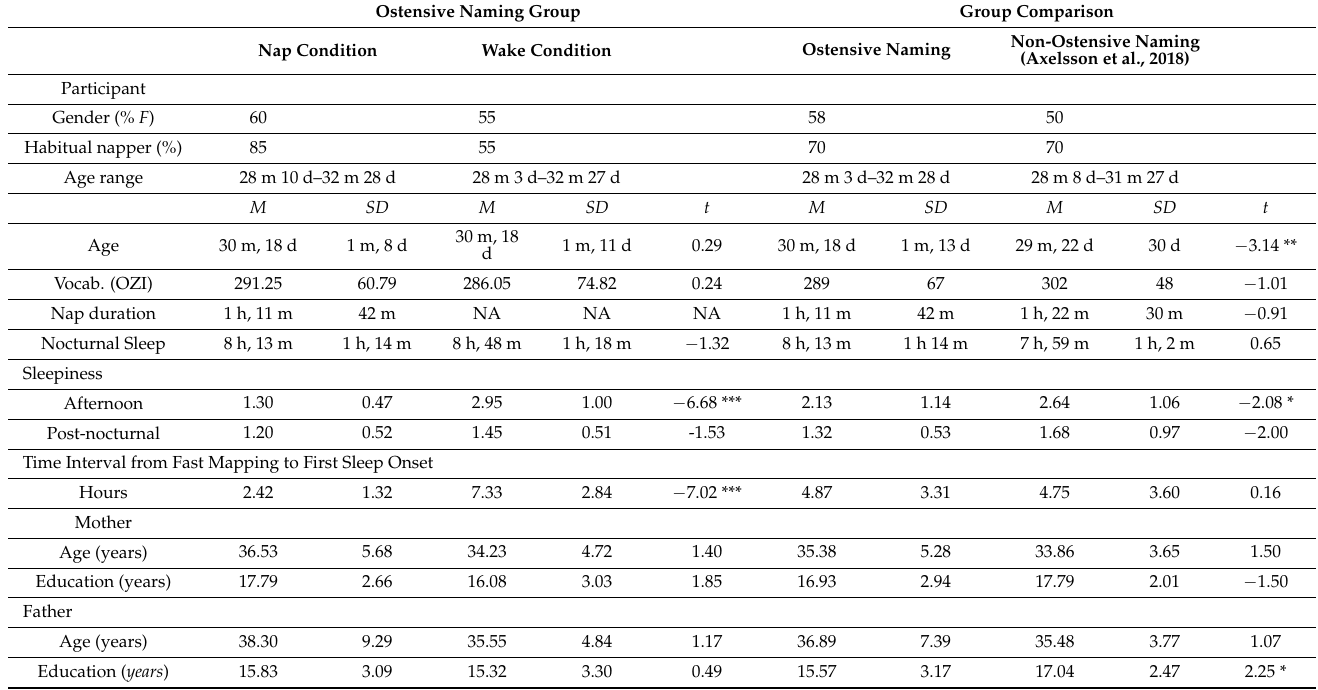
Table 1. Sociodemographic Variable